Question: Provide a one-line summary of what is displayed.
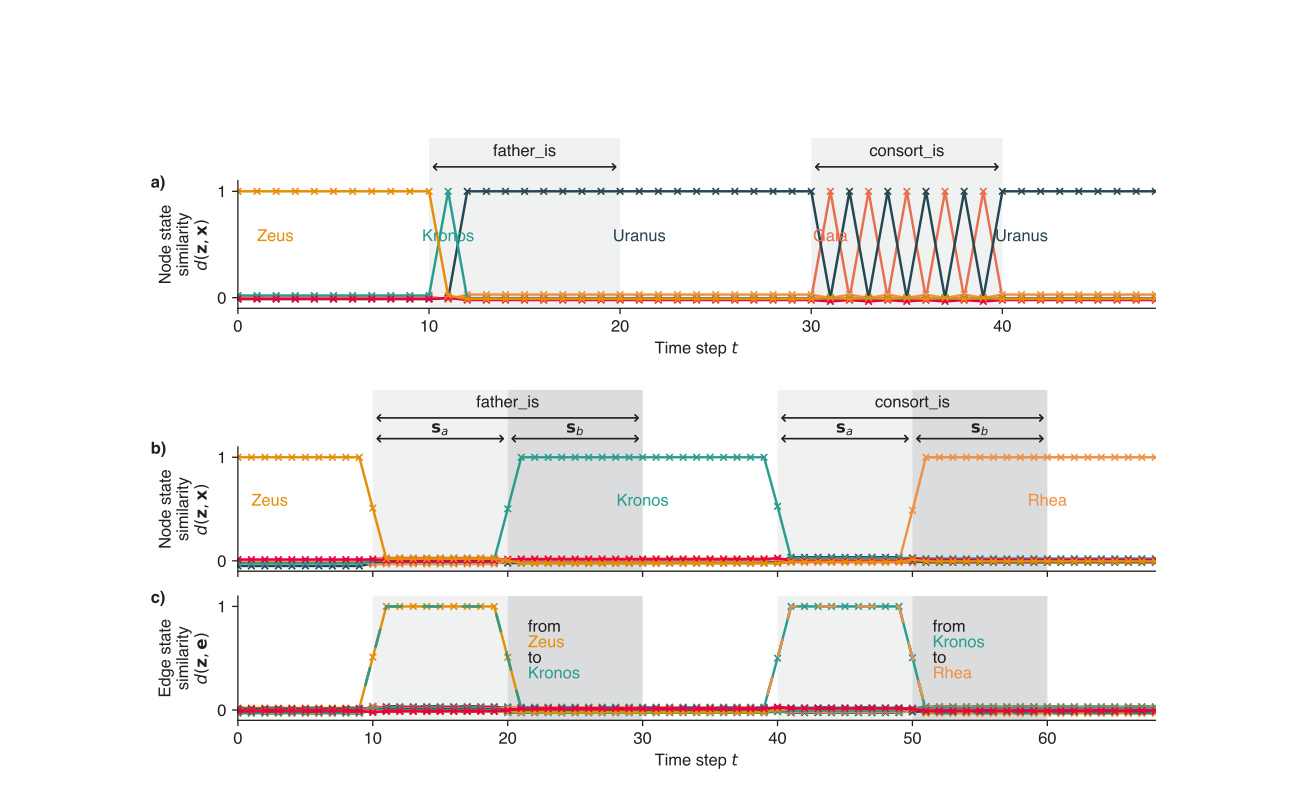
Answer: An attractor network receiving a sequence of stimuli to trigger a certain walk constructed a) without edge states and b) with edge states, with edge state overlaps being shown in c). Due to the consecutive edges in the FSM (Figure 1) with the same stimulus “father is”, the edge-state-less network overshoots and skips the “Kronos” state, stopping instead at the “Uranus” state. Similarly, there is an unwanted oscillation between the states “Gaia” and “Uranus” due to the bidirectional edge with stimulus “consort is”. The addition of the edge state attractors resolves these issues, and allows the network to function robustly when input stimuli are applied for an arbitrary number of time steps.